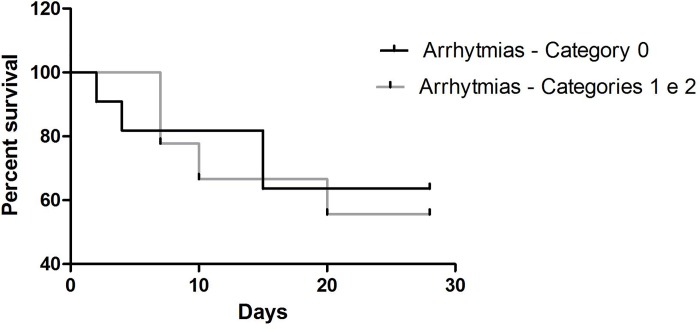
Survival analysis chart according to the presence of arrhythmias on the 24-hour Holter recording.The log-ranked test revealed a p-value of 0.45.